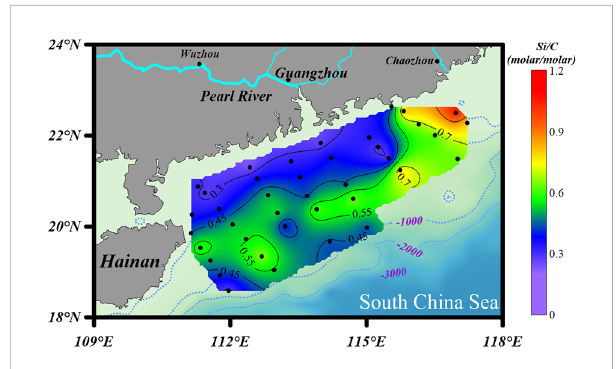
FIGURE 6 Distribution of mean grain size ( F ) in surface sediments of the NSCS.